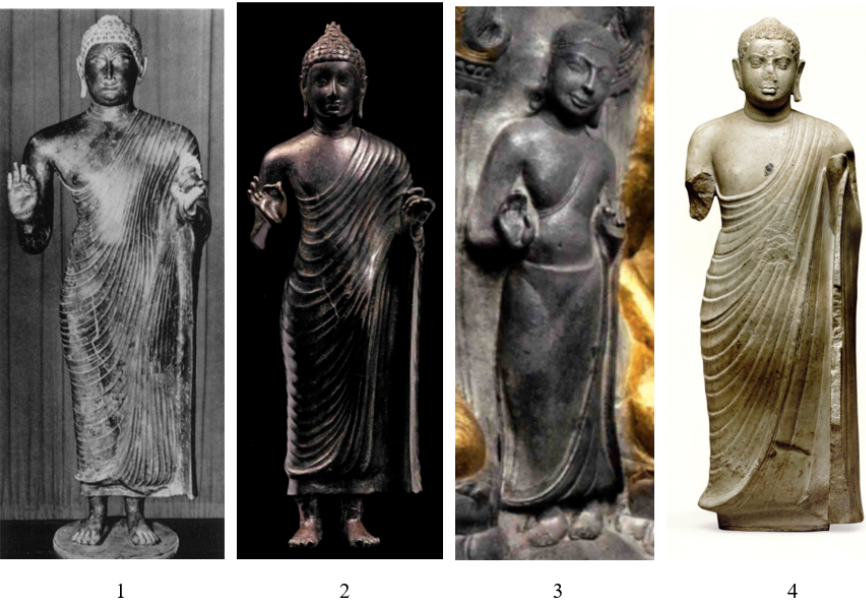
Figure 4. Standing Buddha statues with densely pleated robes covering only the left shoulder (type B). (1): Bronze Buddha, the 6th century, Dong Duong, Quang Nam Province, Vietnam (source: Gris- wold 1966, figure 6a); (2): Bronze Buddha, the 6th to 7th century, Nakhon Ratchasima, Thailand (source: Guy 2014, p. 35, CAT. 5); (3): The image of disciples on the relic box, the 6th century, relic chamber of Khin Ba stupa, Sri Ksetra, Myanmar (Source: Guy 2014, p. 81, CAT. 27); (4): Buddha, Amaravati, the 2nd to 3rd century (Source: China Cultural Relics Exchange Center 2007, p. 59, figure 8).